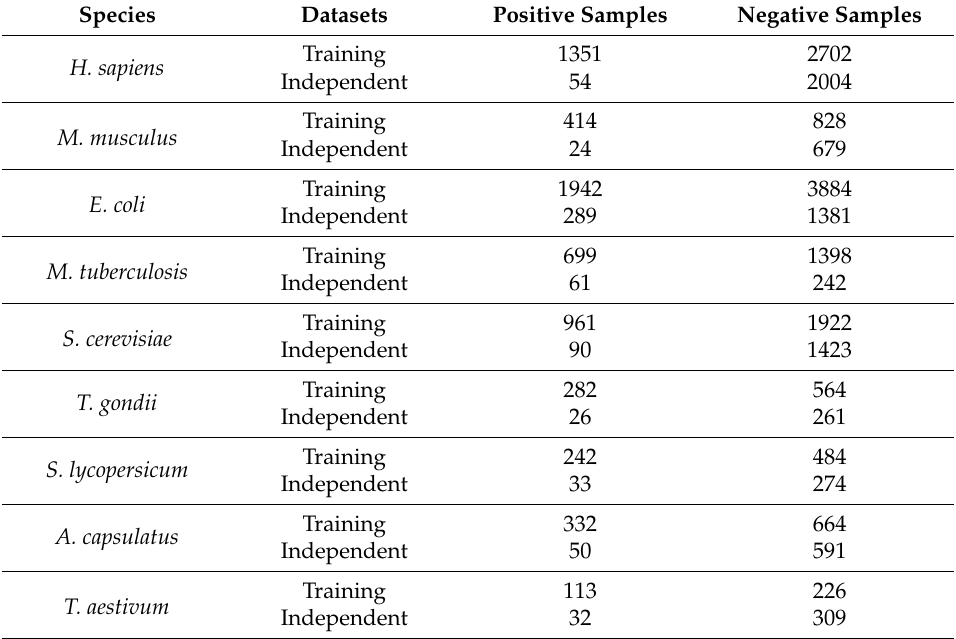
Table 2. Statistics of the positive and negative samples of nine species-specific datasets used in this study.